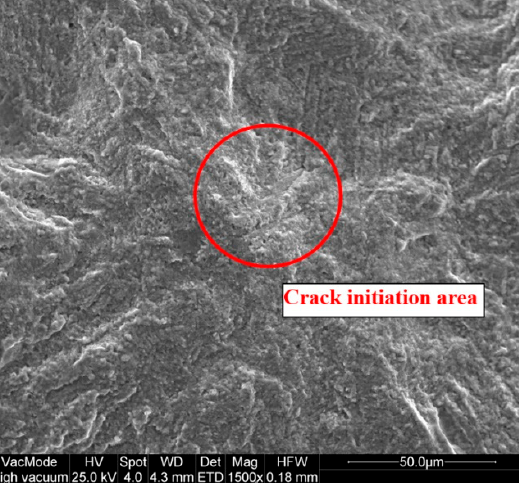
Figure 10. Internal matrix crack initiation of the welded specimen ( σ a = 500 MPa, N f = 1.09 × 10 7 ).